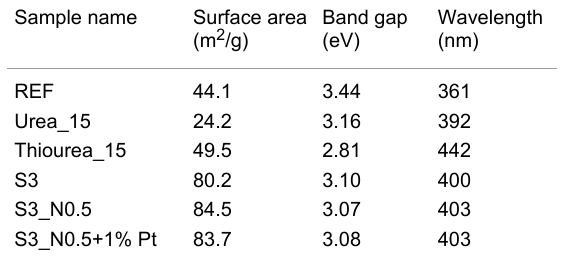
Table 2: BET specific surface area and band gap values for selected